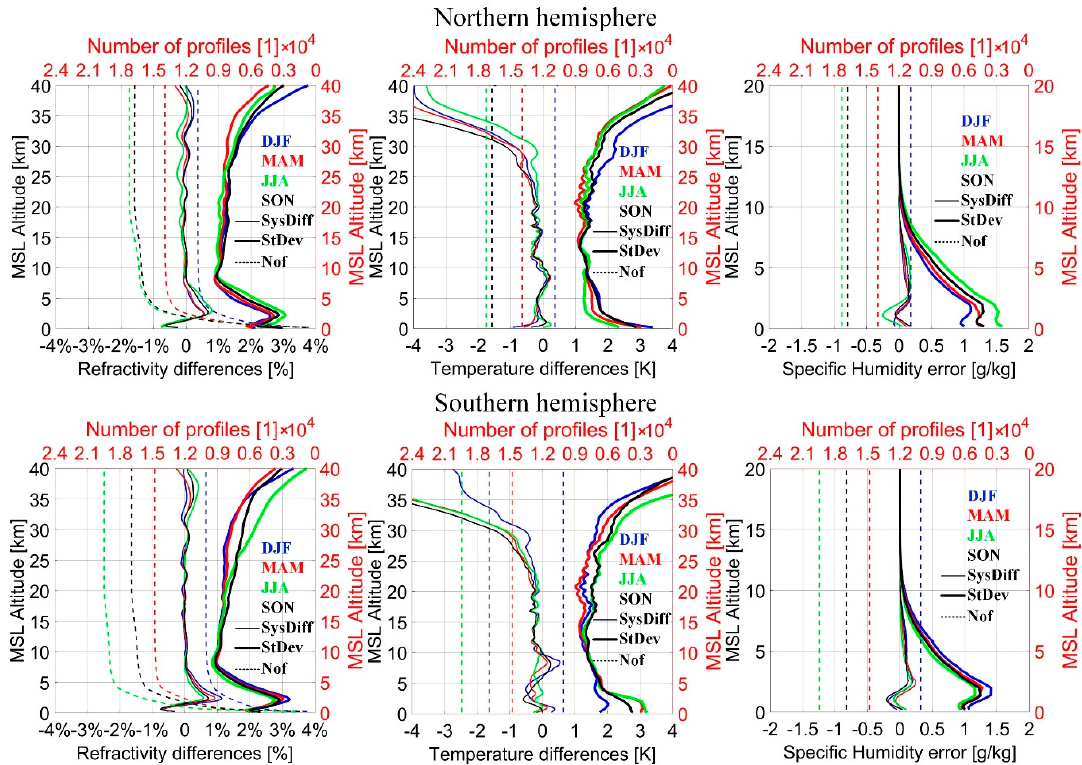
Figure 5. Systematic differences (SysDiff, thin lines) and standard deviations (StDev, thick lines) for the seasons of December, January, and February (DJF); March, April, and May (MAM); June, July, and August (JJA); and September, October, and November (SON); the December profiles are from 2016, all other months are from 2017; Dashed lines indicate the number of profiles (Nof) used for the seasonal statistics.